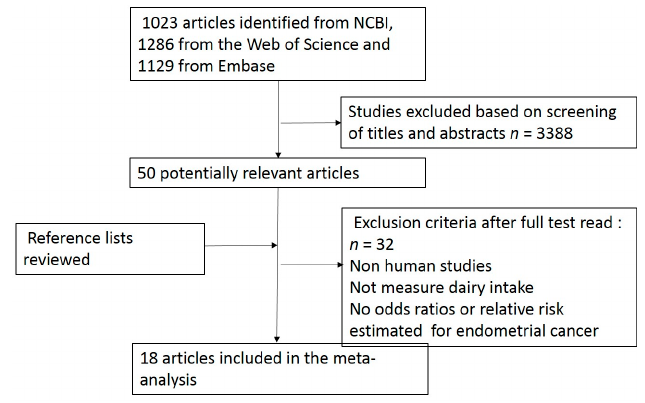
Figure 1. Study flow diagram.